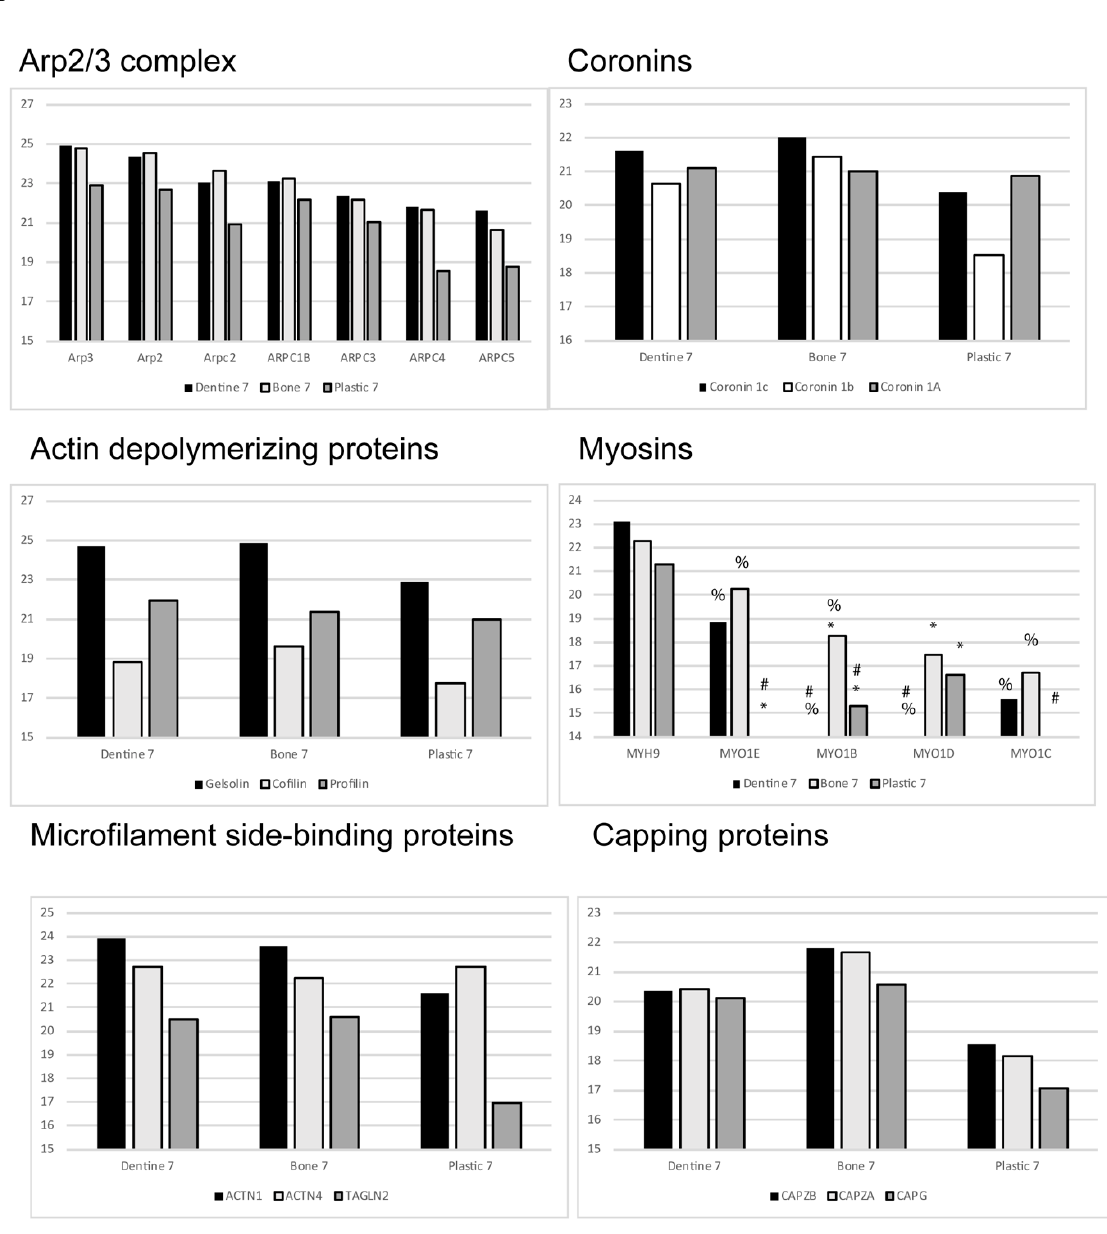
Figure 2. The relative abundance of the actin associate proteins discussed in the current manuscript. These numbers are normalized to actin in extracellular vesicles from conditioned media form osteoclasts resorbing bone at Days 4–7. The raw Day 4–7 data were published previously [25]. Abbreviations: MYH (myosin heavy chain), MYO (myosin), ACTN (alpha-actinin), TAGLN (transgelin), CAP (capping protein). Statistical analysis was performed from Z-scores as described in reference 25. Proteins with Z-scores greater than 1.65 or smaller than 1.65 were considered significantly different. The following symbols are used; # indicates different from bone; % indicates different form plastic; * indicates different from dentine.